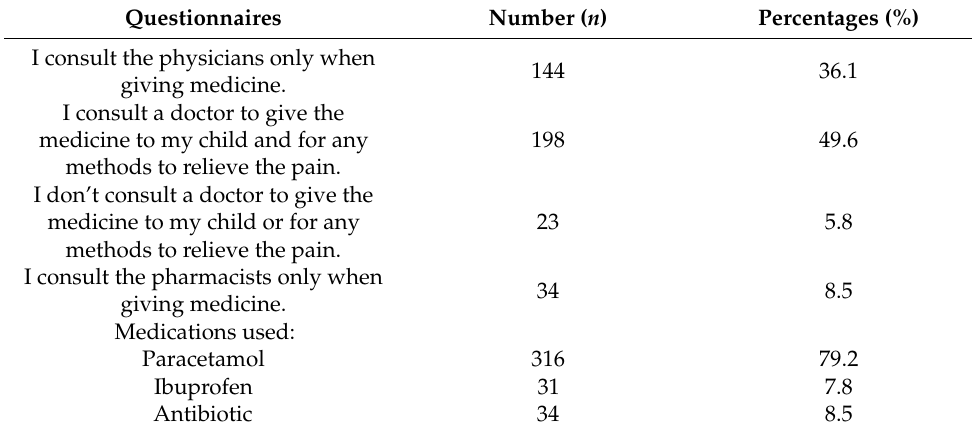
Table 4. Practices of mothers towards pain management.